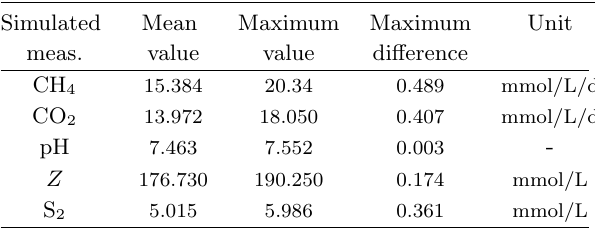
Table 5: The RMSE index for noise-free and noisy mea-